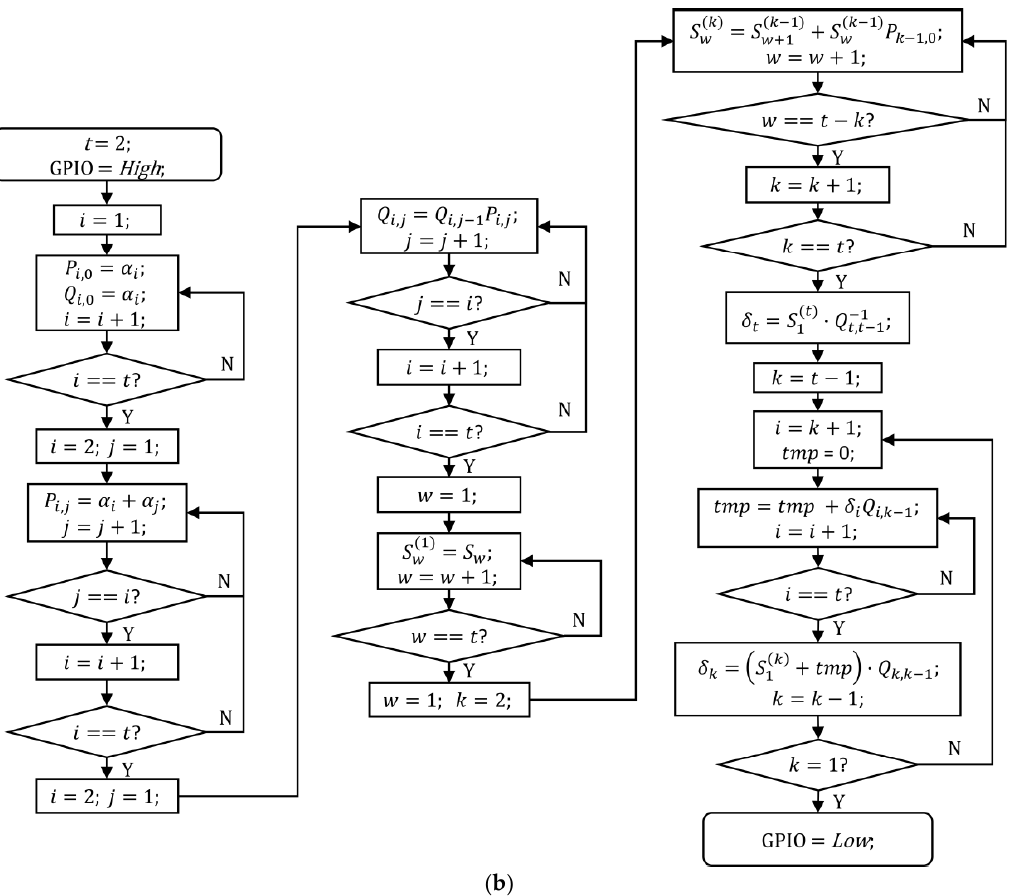
Figure 9. Flowcharts used for the C language implementation of the Forney ( a ) and Lu ( b ) methods. GPIO, general-purpose input/output.